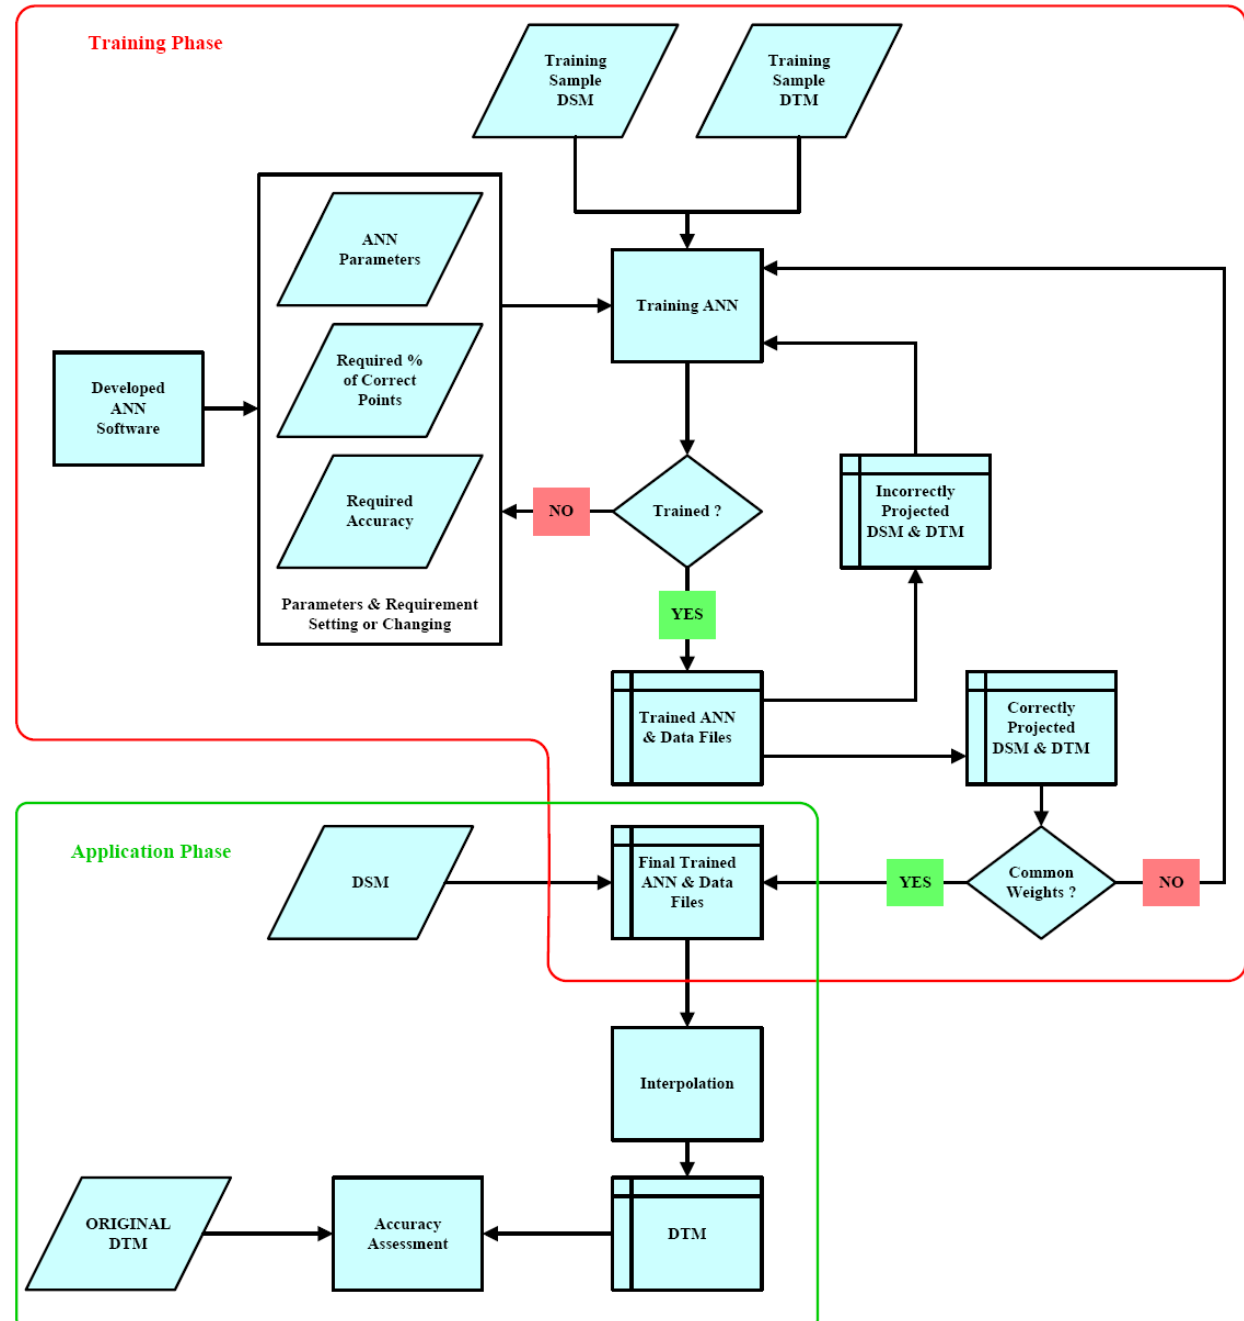
Figure 4. Schematic diagram of the procedure for DTM generation by